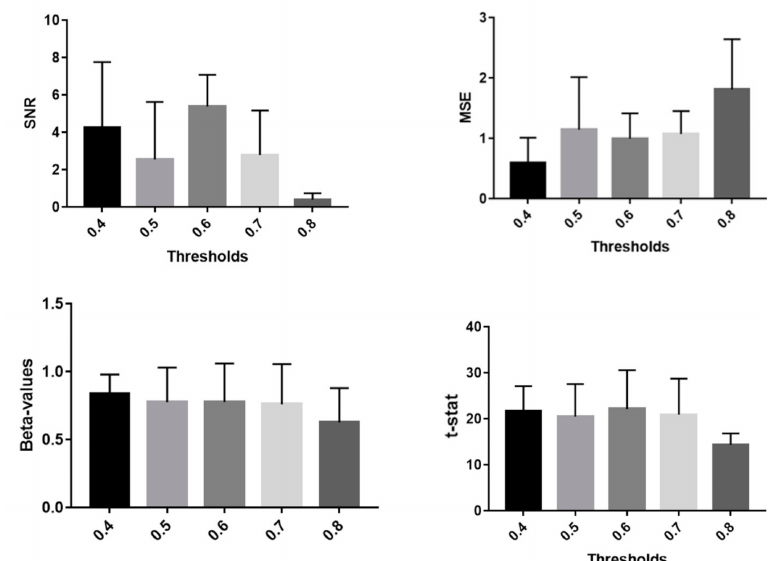
Figure 6. Average and standard deviation of the metrics employed to test the performances of the algorithm as a function of the chosen